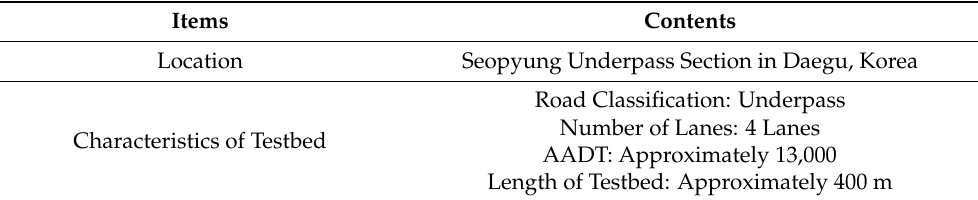
Table 1. Characteristics of Data Collection.